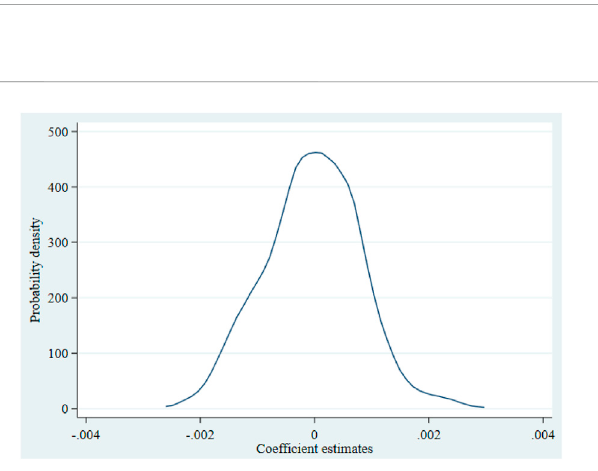
FIGURE 1 Parallel trend test.